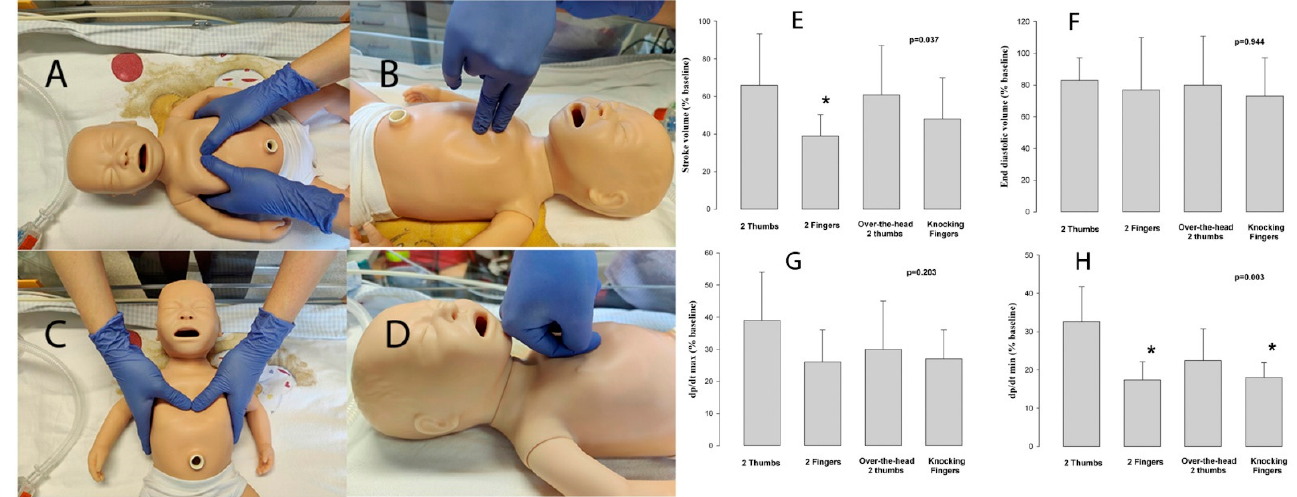
Figure 1. Chest compression techniques: ( A ) 2-thumb-technique, ( B ) 2-finger-technique, ( C ) over-the-head 2-thumb-technique, ( D ) knocking-fingers-technique, ( E ) percentage changes of stroke volume, ( F ) end diastolic volume, ( G ) maximal rate of rise of left ventricular pressure (dp/dt max), and ( H ) minimum rate of change of ventricular pressure (dp/dt min) to baseline. * Significantly different from 2-thumbs-technqiue ( p < 0.05, Tukey).